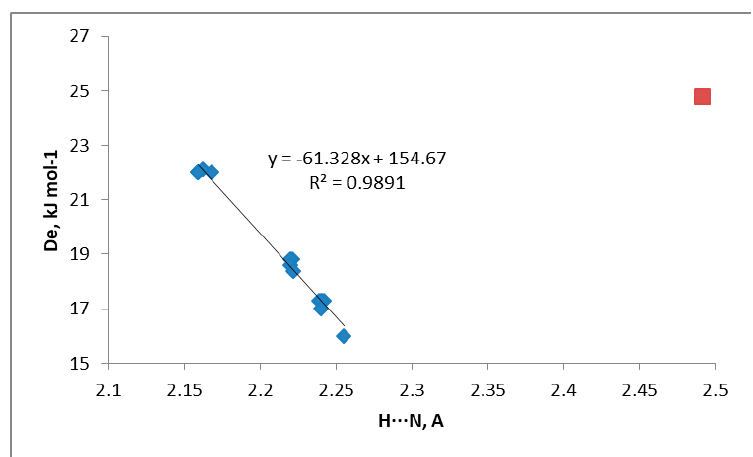
Figure 4. Intermolecular H···N distances, Å, vs. the dissociation energy, kJ·mol − 1 , in the HB complexes. The o -B 10 H 12 C 2 :NCH complex is indicated with a red square, and it is not included in the correlation equation.